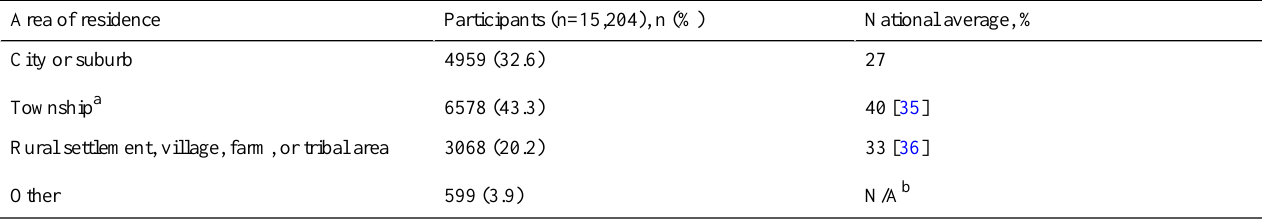
Table 2. Representativeness of the sample by area of